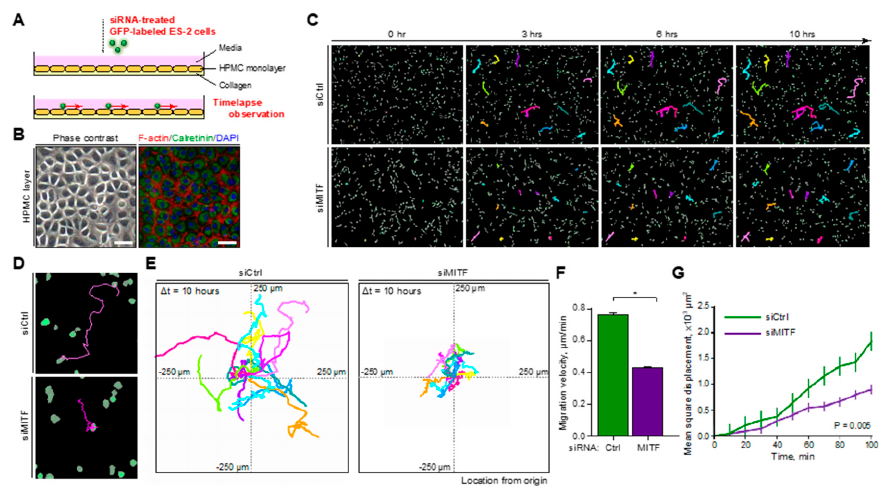
Figure 3. MITF is associated with peri-mesothelial migration of OvCa cells. ( A ) Schematic protocol of the peri - mesothelial migration assay. ( B ) Representative phase - contrast and immunofluorescence images of an HPMC monolayer. Scale bar: 50 μ m. ( C ) Time - lapse images and movement locus of randomly selected GFP - labeled ES - 2 cells treated with control or MITF - targeted siRNA. ( D ) Representative images of the traced movement locus of GFP - labeled ES - 2 cells treated with control or MITF - targeted siRNA. ( E ) Integrated traced movement loci of ES - 2 cells in each treatment group. ( F , G ) Average migration velocity and chronological mean square displacement of GFP - labeled ES-2 cells treated with control or MITF - targeted siRNA. * p < 0.05 ( t - test).